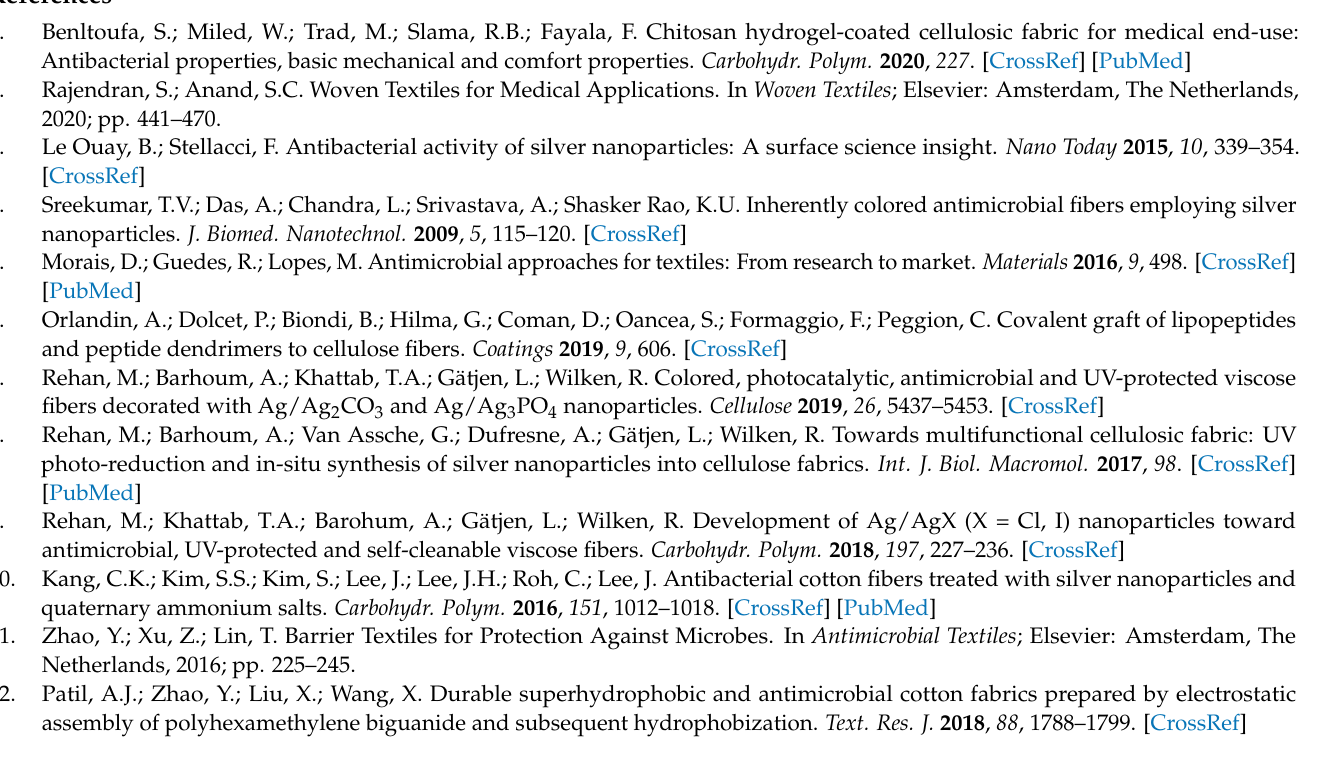
(Cs), Figure S2: Raman Spectra of the cotton gauze fabrics coated with Ag NPs and HAp/Ag NPs after washing and drying, Figure S3. TGA thermal analysis of cotton fiber samples coated with Ag and HAp/Ag NPs: (a) TGA weight loss; (b) Weight derivatives. Figure S4: SEM-EDX analysis and their corresponding SEM image of the cotton fibers coated with HAp/Ag NPs. Table S1. Antimicrobial activity, air permeability, water absorption, and tensile strength of the prepared cotton gauze